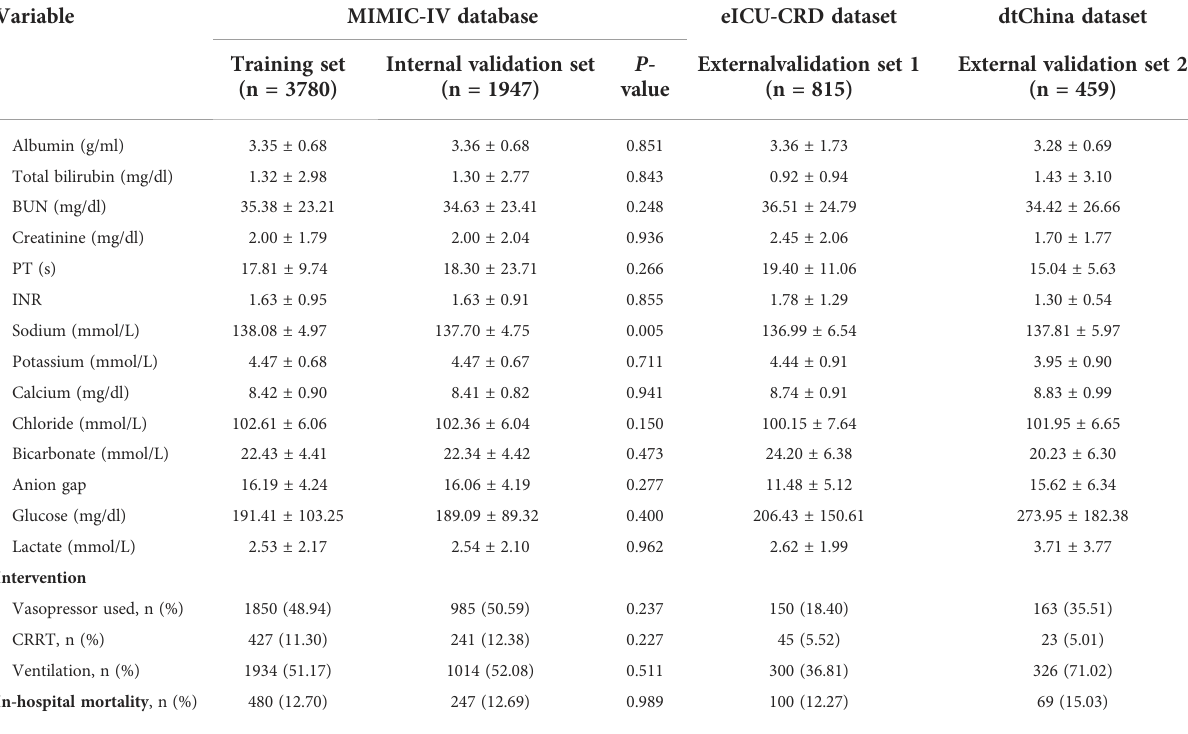
Figure 8. The top three models for internal validation set were